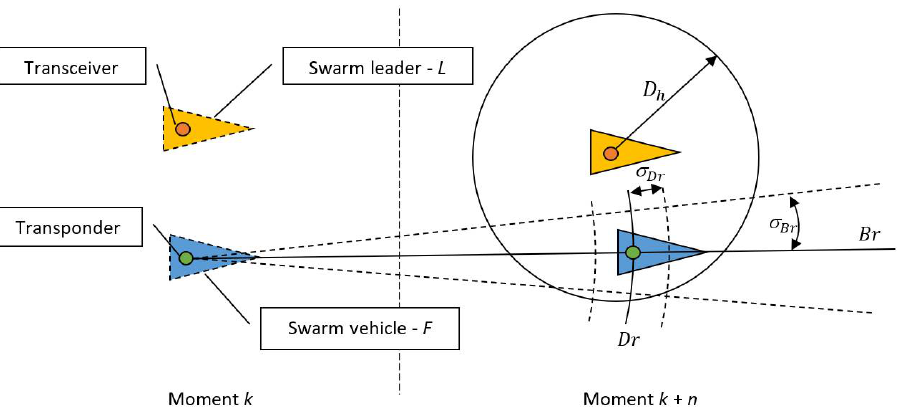
Figure 1. Idea diagram of the navigation measurement system in the leader–single swarm vehicle relation.